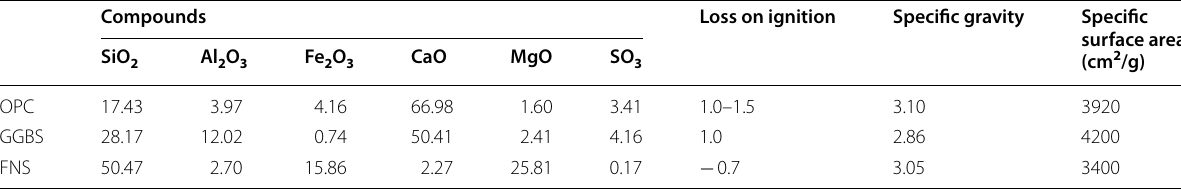
Table 1 Chemical and physical characteristics of binders (%).